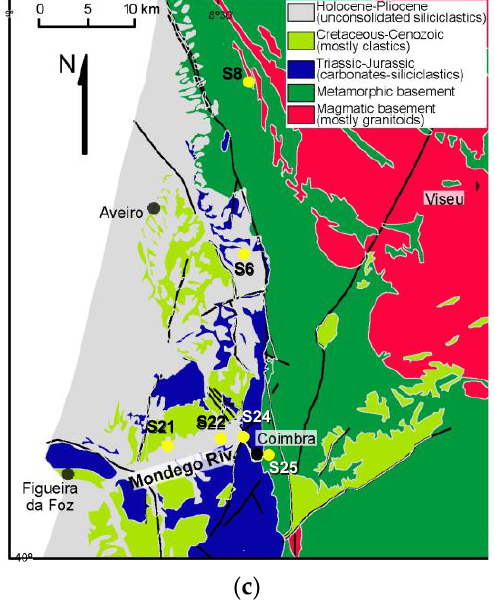
Figure 2. ( a ) Map showing the of total Portuguese territory and the silica source collecting locations (marked with starred yellow balloons) (Google Maps). ( b ) Map (detail) with the locations and designation for the collected silica sources (marked with starred yellow balloons) and the location of Monastery of Santa Clara-a-Velha (marked with a hearted pink balloon) (Google Maps). ( c ) Geological map of the region. Table 1. Table with the location (GPS coordinates) of the collected silica sources, the collecting date, the designation code and the geological source of the sands. Location GPS